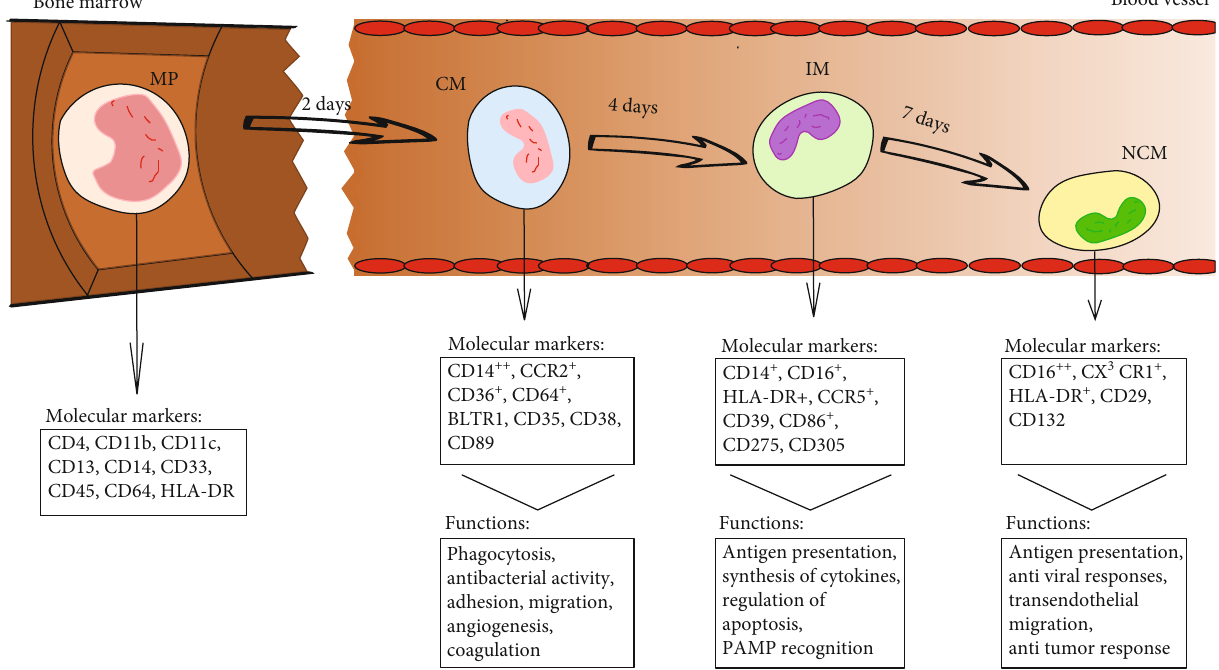
Figure 1: Human monocyte subsets in health. Human monocytes mature in the bone marrow and are subsequently released into the circulation as CD14++classical monocytes. Progressively, classical monocytes (CD14++CD16 − ) give rise to nonclassical monocytes (CD14dimCD16++) through an intermediate step of CD14+ CD16+ monocytes. MP: myelomonocytic progenitor; CM: classical monocytes; IM: intermediate monocytes; NCM: nonclassical